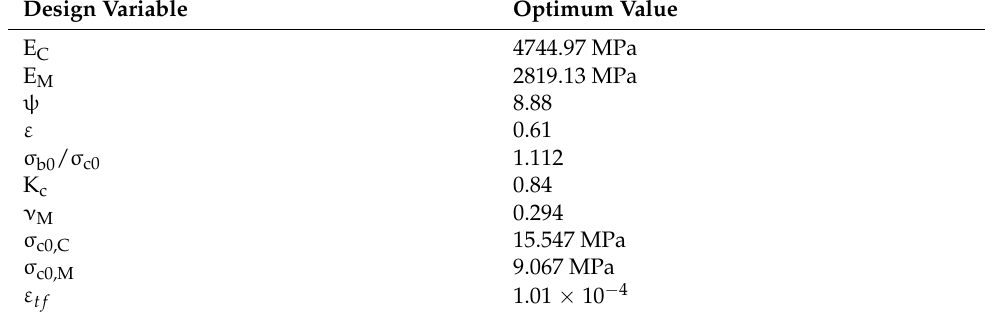
Table 3. Optimal material properties of the small scale wall prism.